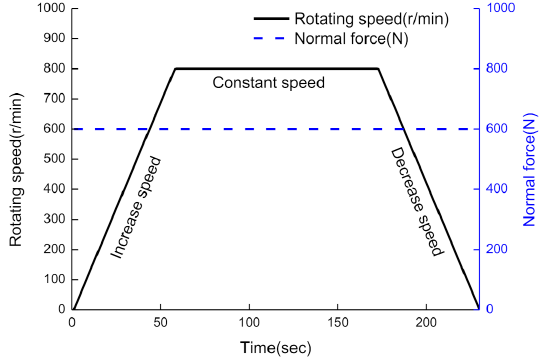
Figure 7. Typical test condition curve.